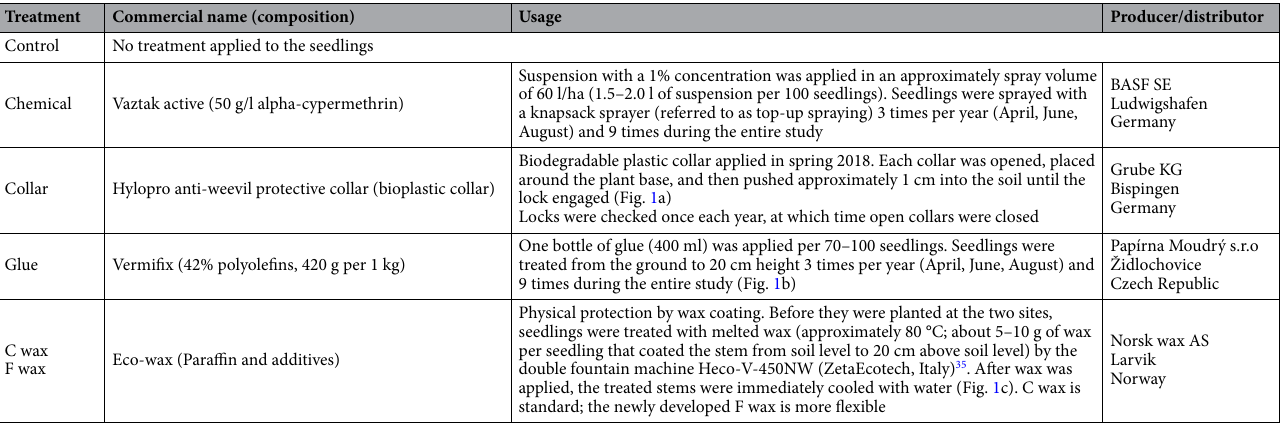
Table 1. Description of